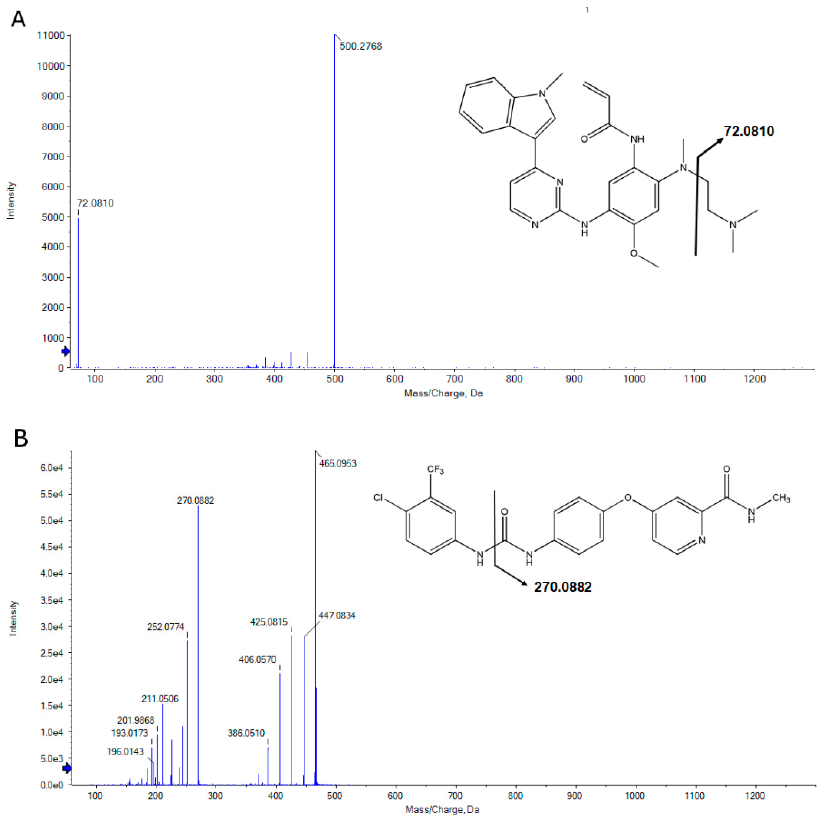
Figure 2. Product ion scan of osimertinib 500.2768 → 72.0810 ( A ), and IS 465.0953 → 270.0882 ( B ).